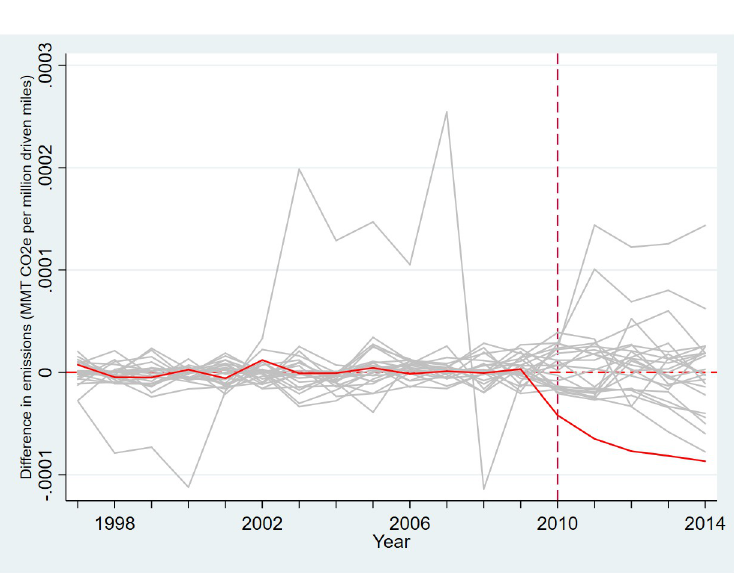
Fig 3. Placebo test of the synthetic control estimation to measure the effect of the LCFS on emissions.